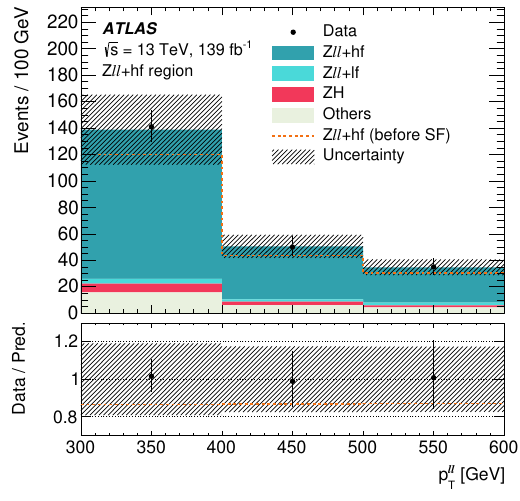
Figure 11. Distribution of p ‘‘ in Z → ‘ + ‘ − events produced in association with heavy-flavour jets. T The background labelled as ‘Others’ contains W +jets, diboson, t ¯ t and single-top-quark events. The lower panel shows a bin-by-bin comparison of the data and the predicted total background, in terms of event yield ratios. The hatched bands represent combined statistical and systematic uncertainties.